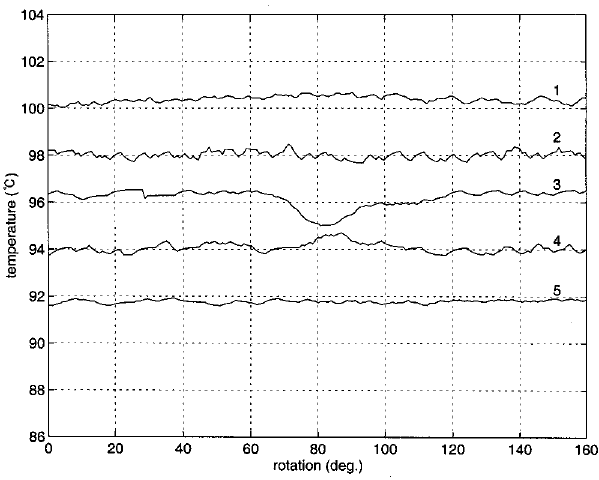
Figure 7. Variations of measured temperatures in the pipe